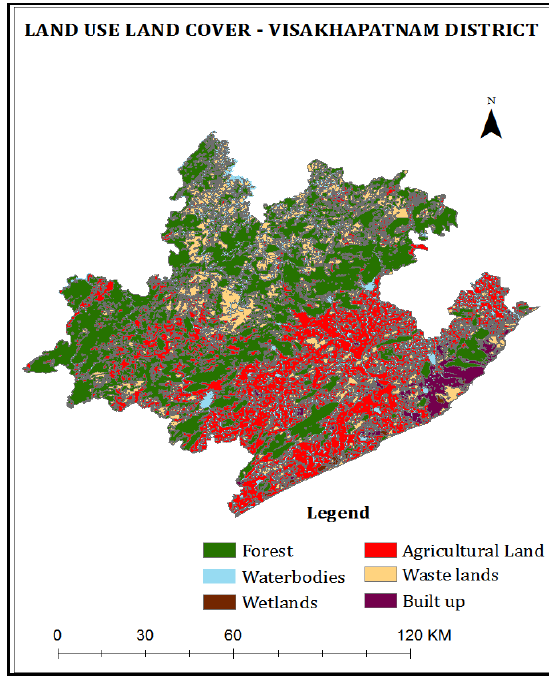
Fig 2: Land use Land cover map